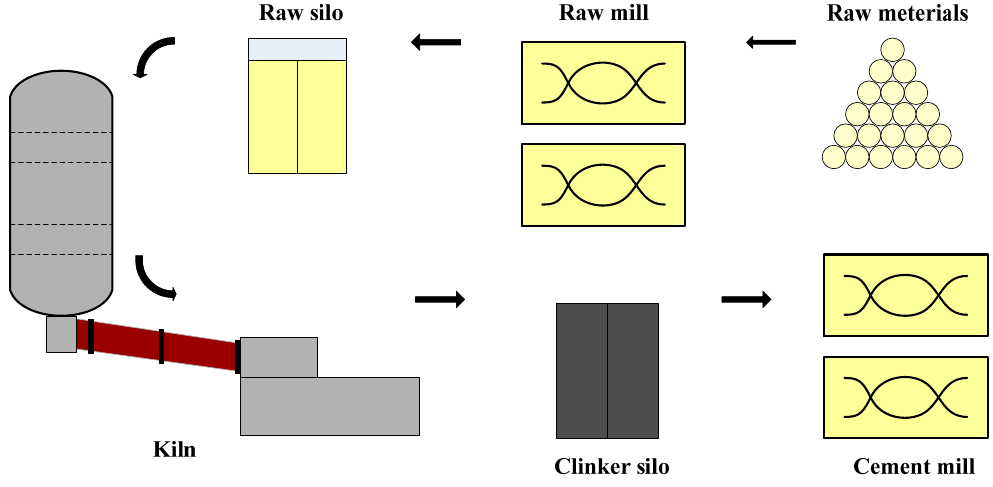
Figure 4. Production diagram for cement manufacturing process (A “2:2” raw to cement mill configuration is